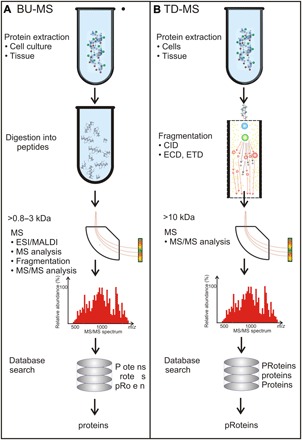
Inferring the primary structure of protein by MS.MS uses two approaches to infer the primary structure of a protein: (A) a bottom-up (BU-MS) approach that is used prevalently and (B) a top-down (TD-MS) approach that analyzes intact protein <70 kDa. According to the process flow in BU-MS, to infer the primary structure, the proteins are first digested by trypsin, and then the resulting peptides 0.8 to 3 kDa in size, on average, are analyzed in the gas phase by MS. First, the mass of the peptides are determined, and then peptide ions are fragmented to inform on the sequence using tandem MS (MS/MS). BU-MS does not inform on the entire sequence but only fragments as represented by the incomplete word “protein.” In contrast, in TD-MS, intact protein ions are introduced in the gas phase and are fragmented (10 kDa in size on average) and analyzed by MS to identify the mass of the protein and protein ion fragments, which are then puzzled out to reveal the primary structure of the protein. Both methods subsequently rely extensively on the searches through databases to identify the protein. The entire sequence can be revealed this way along with PTMs (represented by the capital letter in the word “pRoteins”). CID, collision-induced dissociation; ECD, electron-capture dissociation; ETD, electron-transfer dissociation.